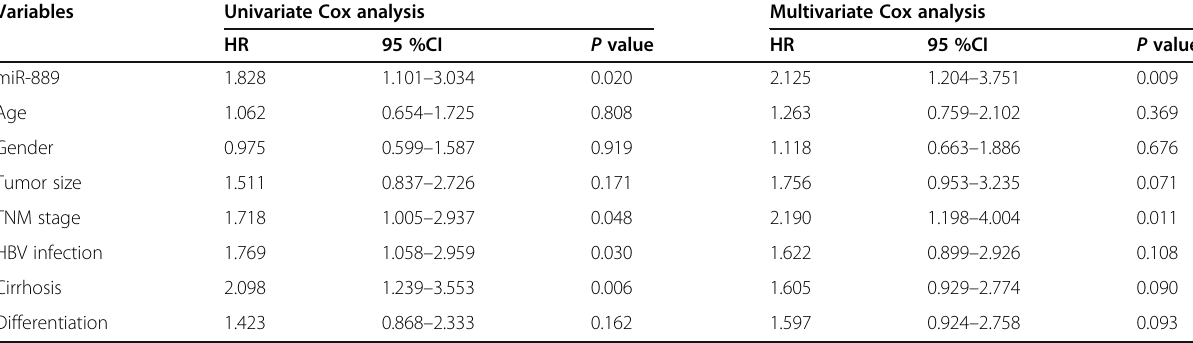
Table 2 Cox analysis of factors for survival of hepatocellular carcinoma patients